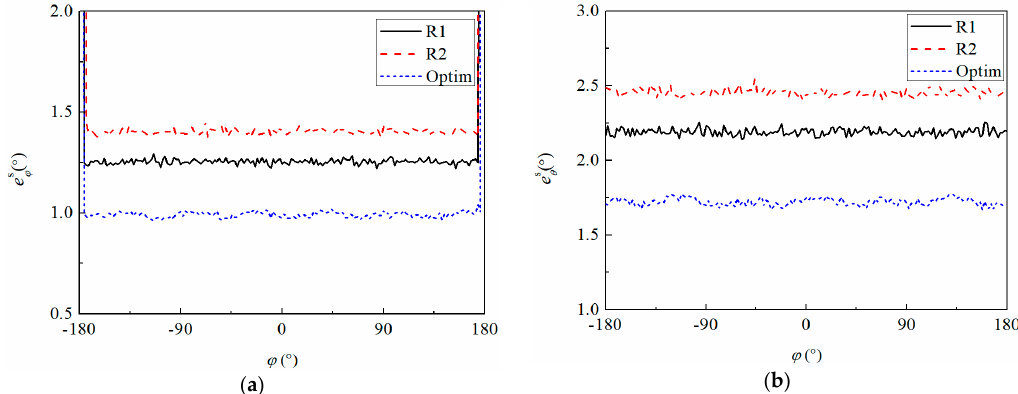
Figure 14. Comparison of average direction-of-arrival (DOA) errors for optimized and reference arrays: ( a ) average error of azimuth angle; ( b ) average error of elevation angle.